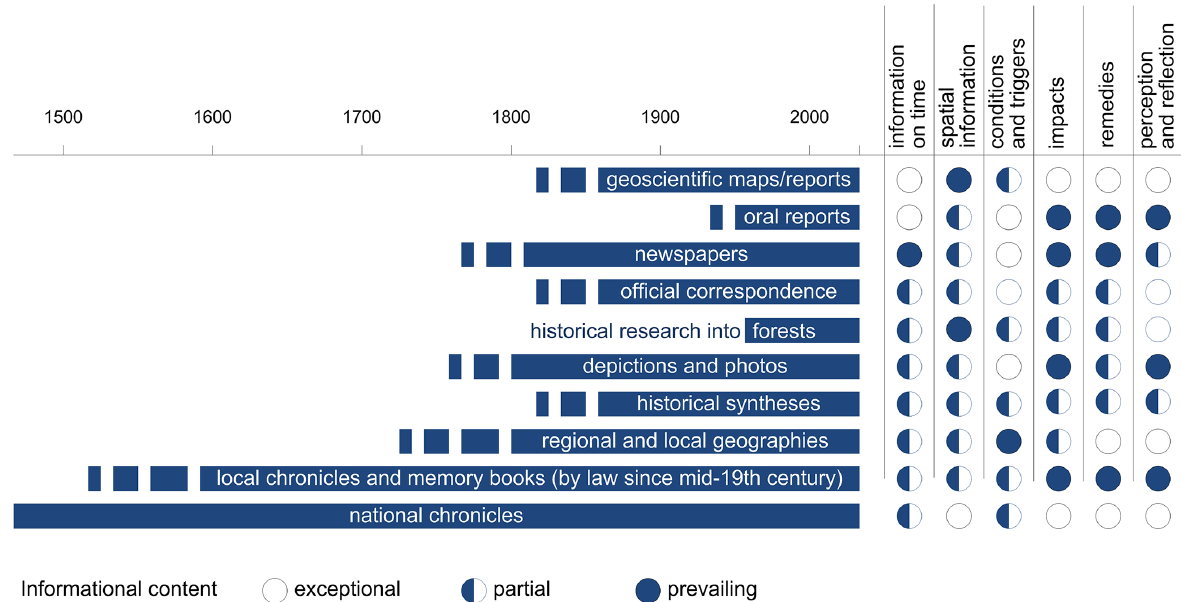
Figure 2. An overview of available documentary data applicable for historical landslide research in Czechia with respect to their time coverage and informational